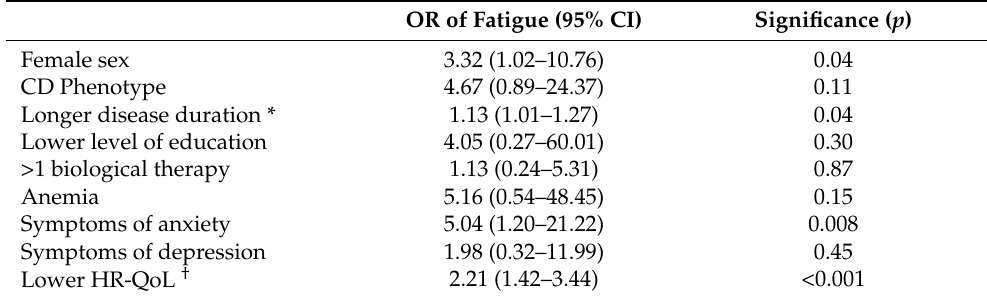
Table 3. Multivariate analysis of factors associated with fatigue in univariate